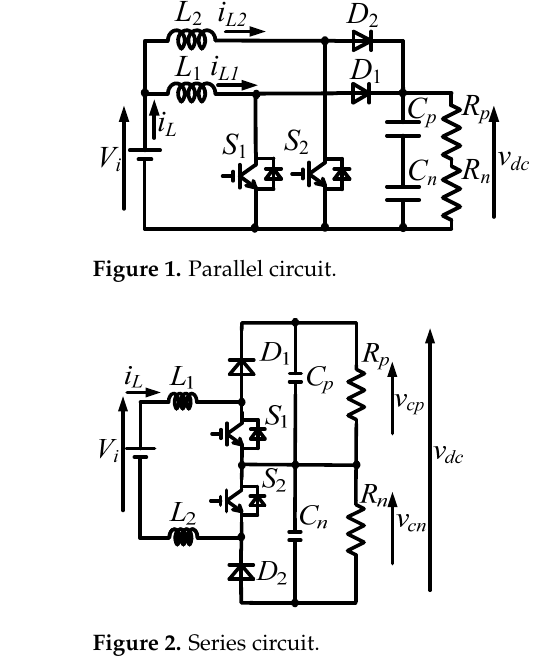
Figure 2. Series circuit.